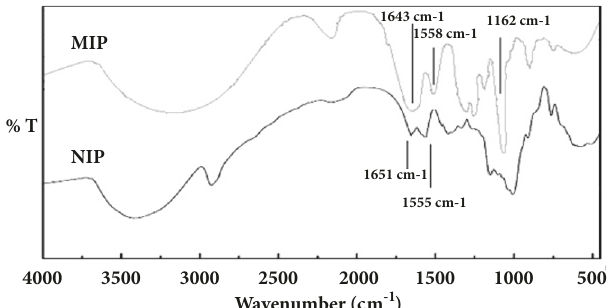
Figure 1: MAFol synthesis.